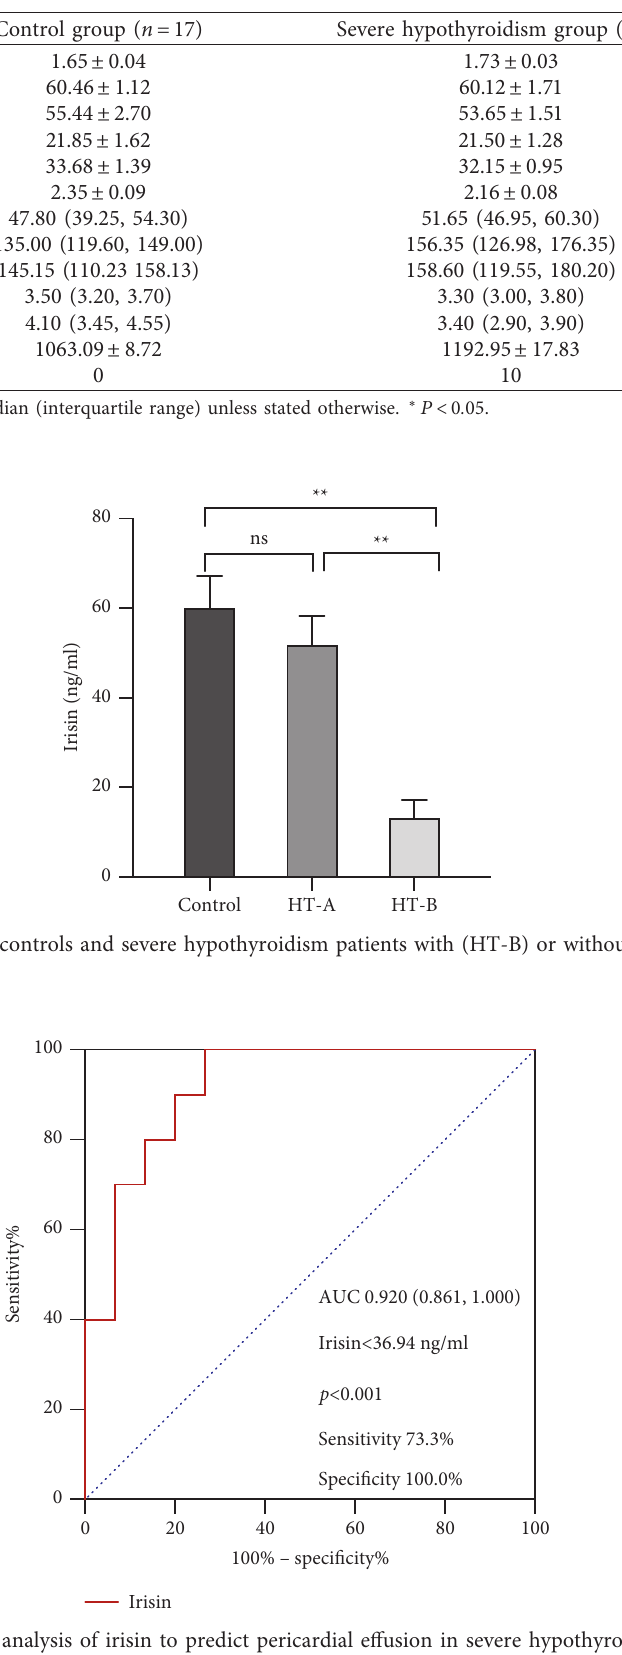
Table 2: Cardiovascular magnetic resonance parameters of control and severe hypothyroidism groups.